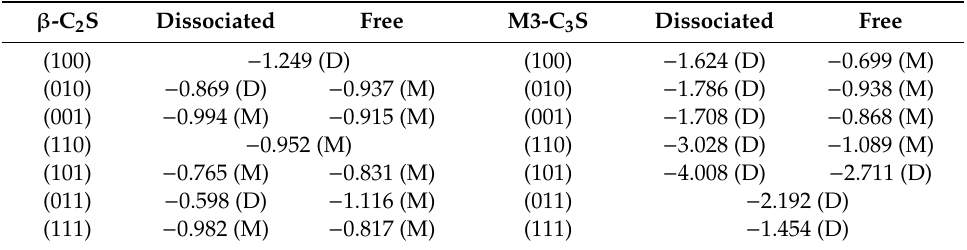
Table 2. E ad (eV) of a single H 2 O over Mg-doped surfaces of β -C 2 S and M3-C 3 S. β -C 2